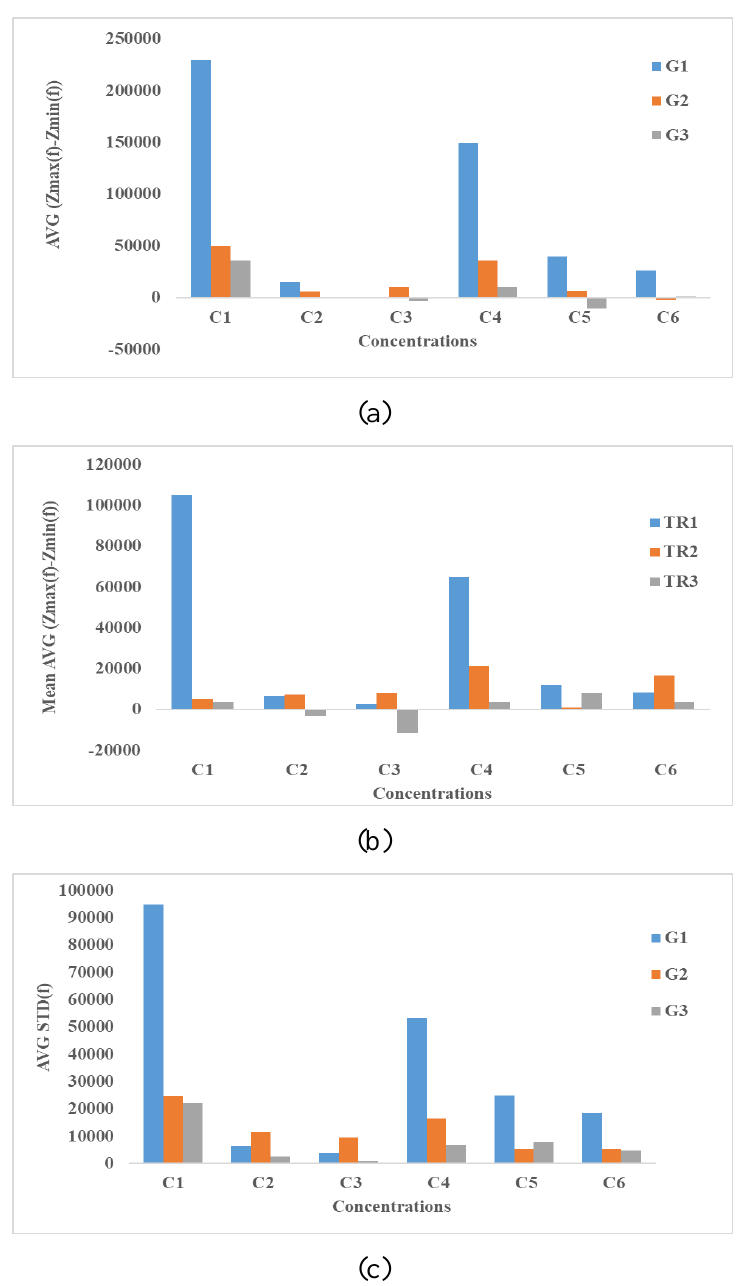
Figure 11. Integrated Impedance Spectroscopy results using equations: ( a ), ( b ) and ( c ) at different concentration of SPIONs (C1–C6) and three different groups (G1–G3).